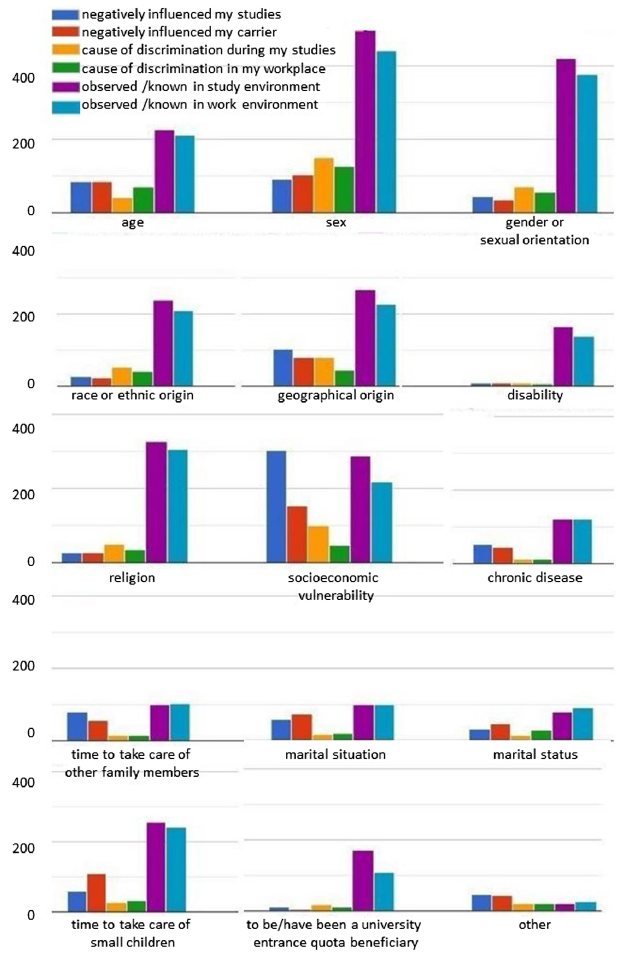
FIG. 5. Causes of difficulties. Number of (nonexclusive) responses for each factor associated with negative influence or discrimination of the respondent or colleagues given in the caption. Horizontal lines are drawn as references.